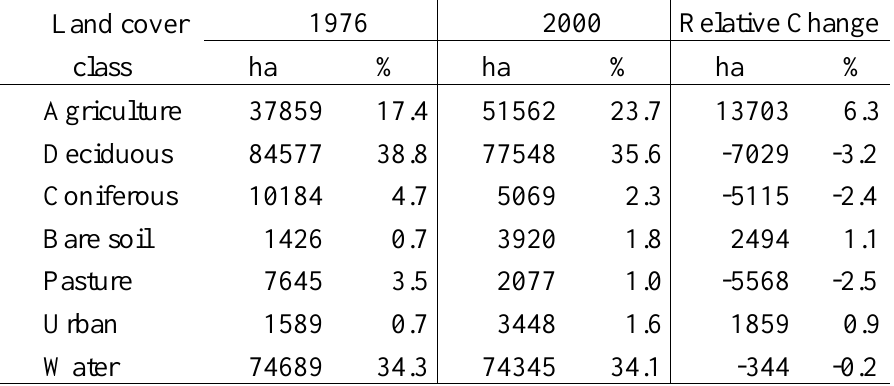
Table 3. Summary of Landsat classification area statistics for 1976 and